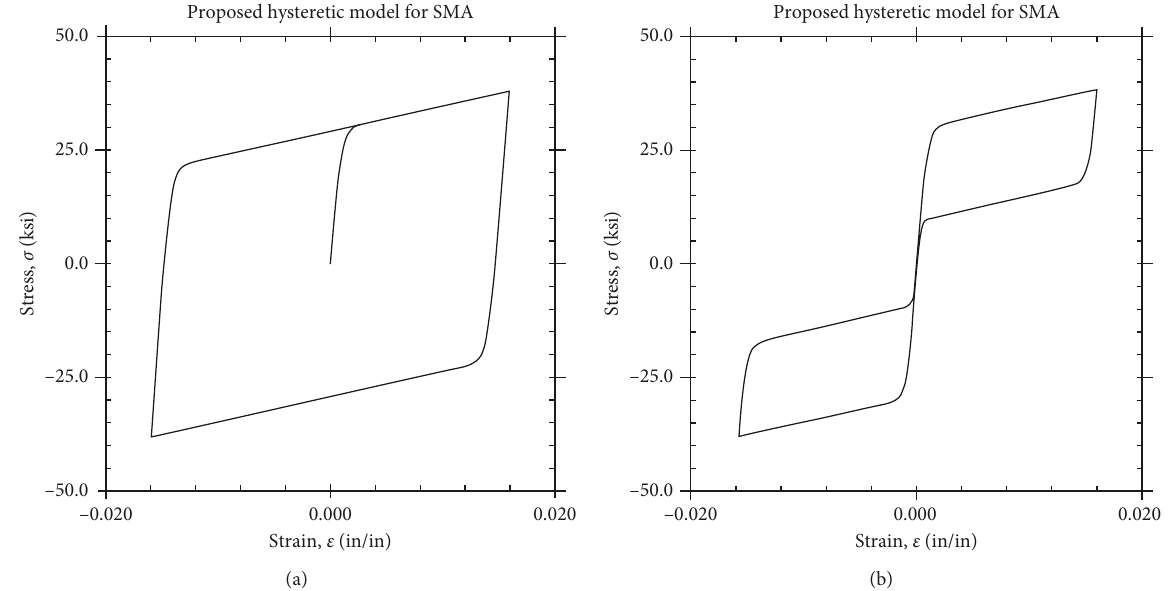
Figure 3: Typical cyclic response of Graesser– Cozzarelli model for (a) f